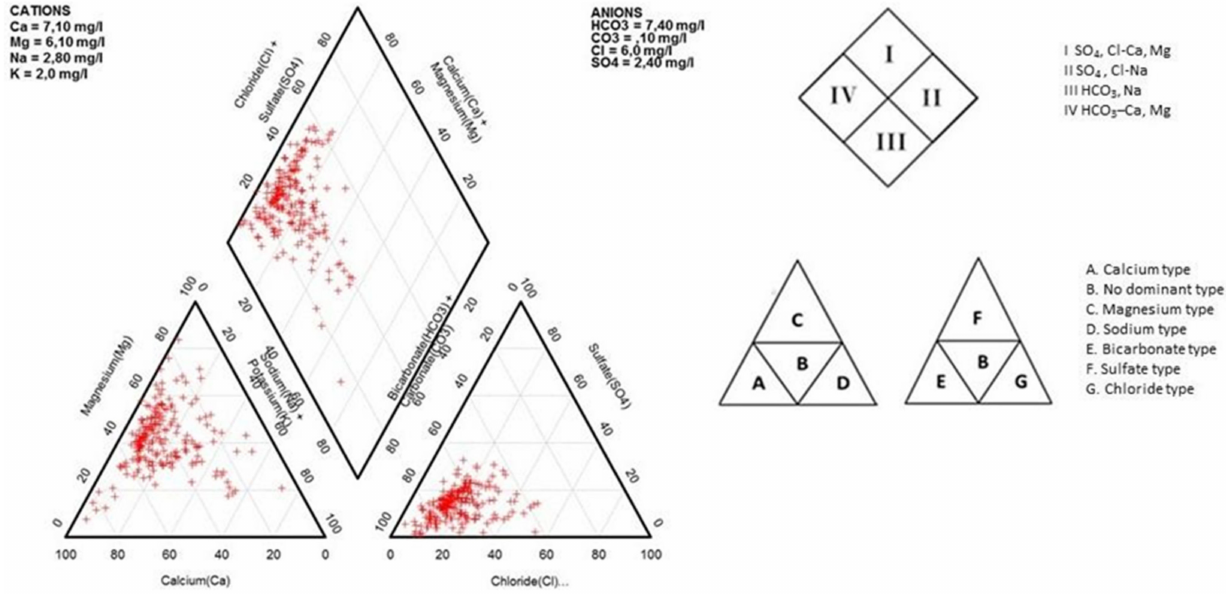
Figure 18. Piper’s diagram for water